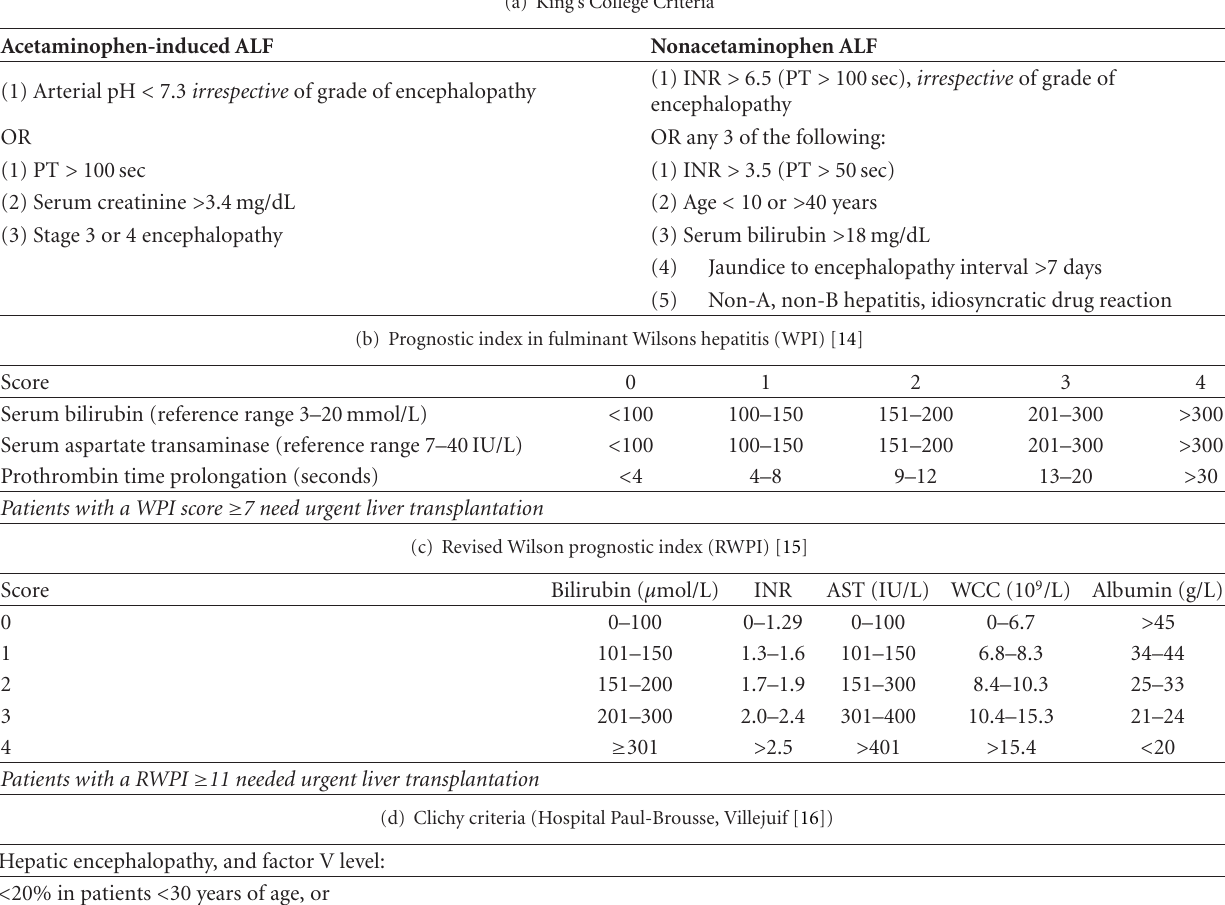
Table 5: Criteria for liver transplantation in acute liver failure